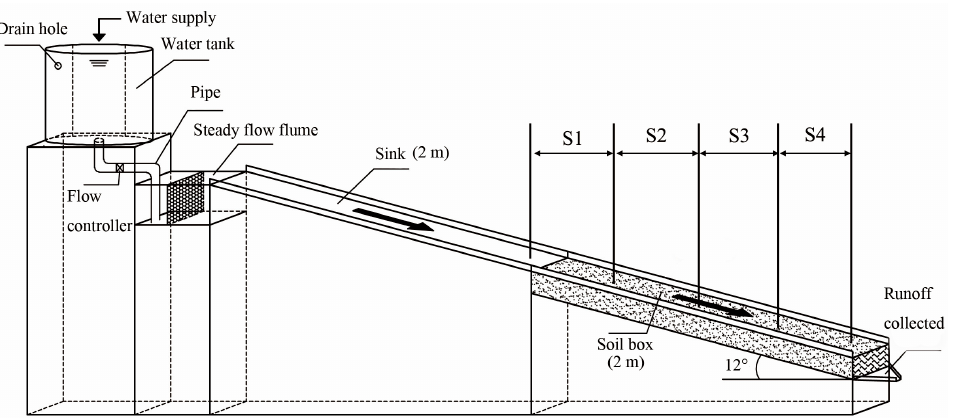
Figure 2. The scour experimental system.